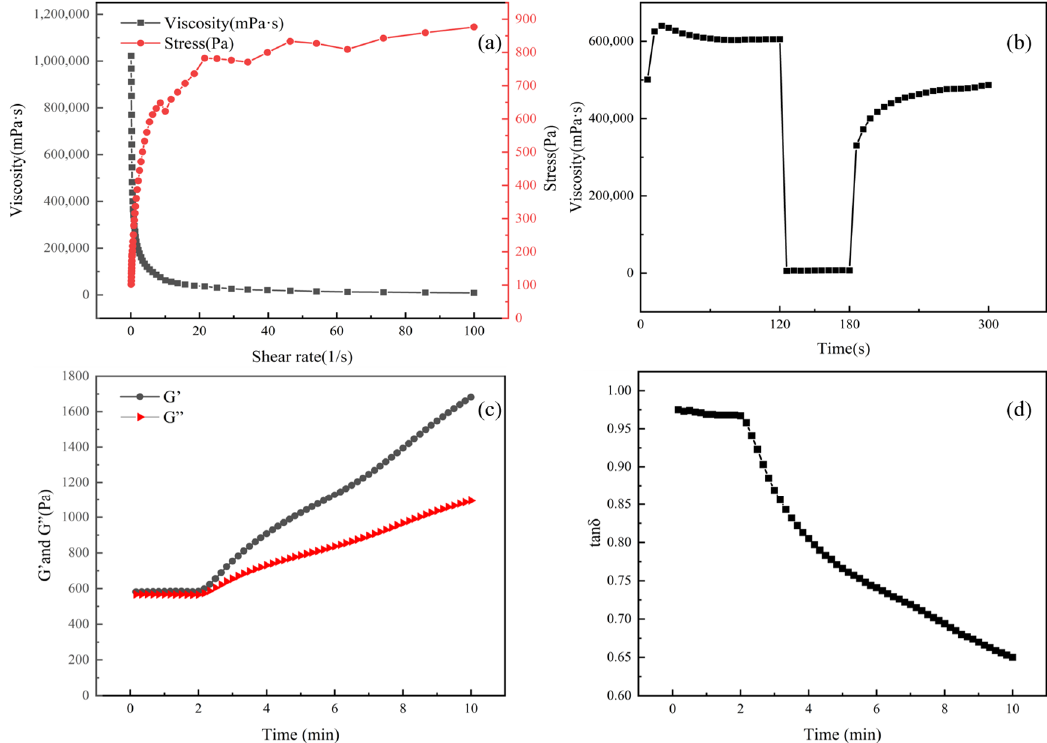
Figure 9. Rheological properties of hydrogels containing 5% PEGDA and SA/CMCS (3:1). ( a ) Vis- cosity versus shear rate. ( b ) Viscosity versus light exposure time. ( c ) Loss modulus and energy stor- age modulus. ( d ) Ratio between loss modulus and energy storage modulus.